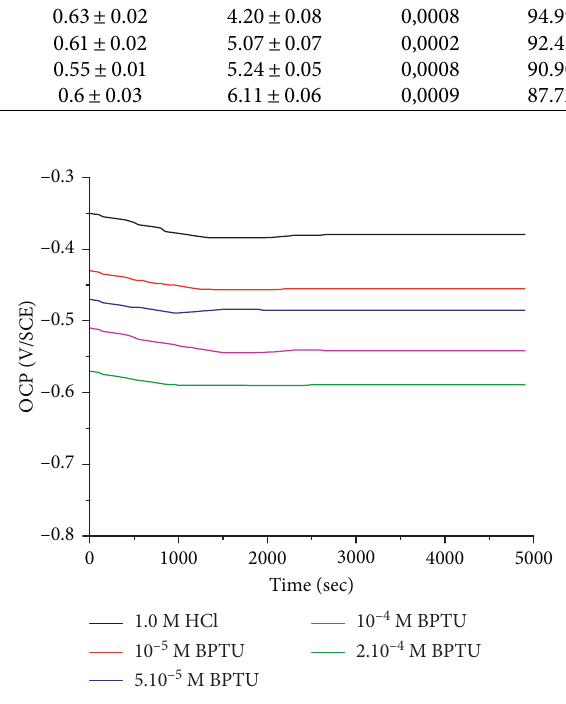
Figure 5: Open circuit potential for mild steel with different concentrations of